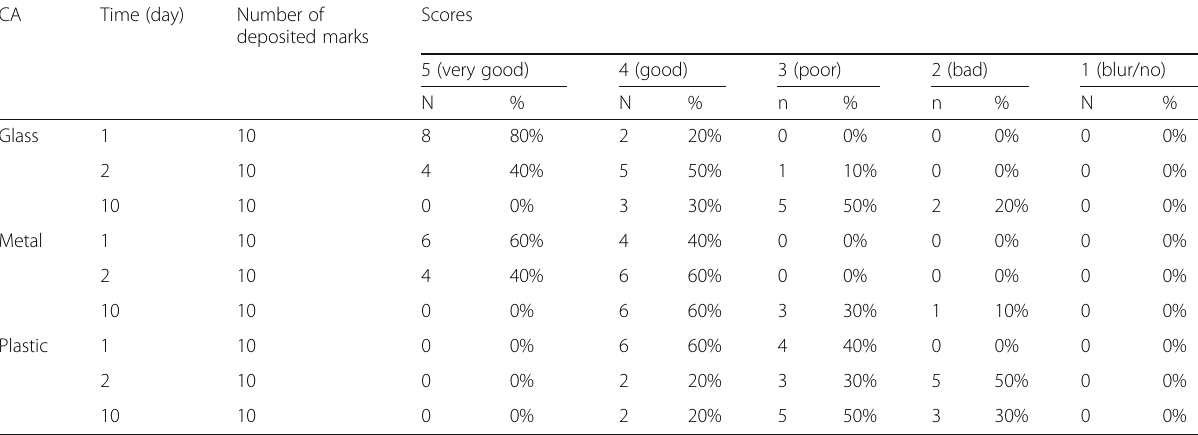
Table 6 Fingerprints development scores using CA technique on glass, metal and plastic surfaces submerged in fresh water at 1, 2 and 10days ’ intervals according to fingerprints quality assessment scale